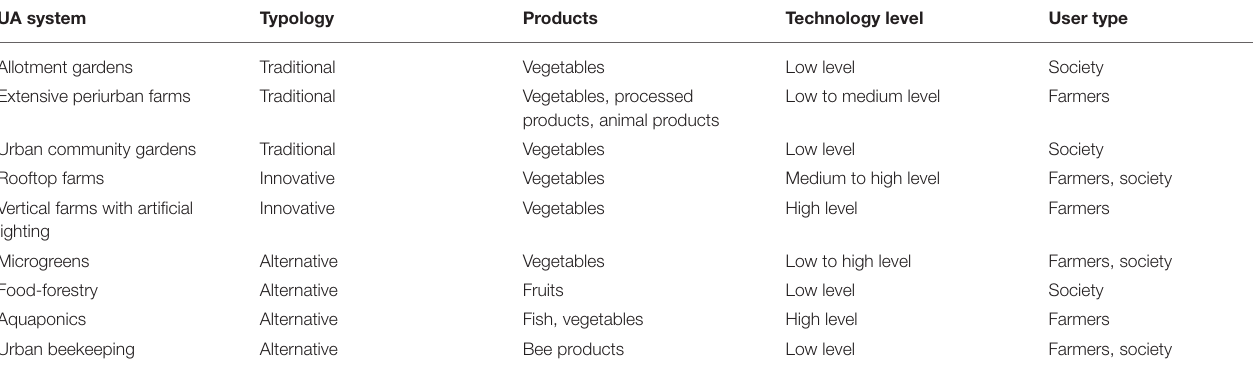
TABLE 4 | Main UA system typologies in the Global